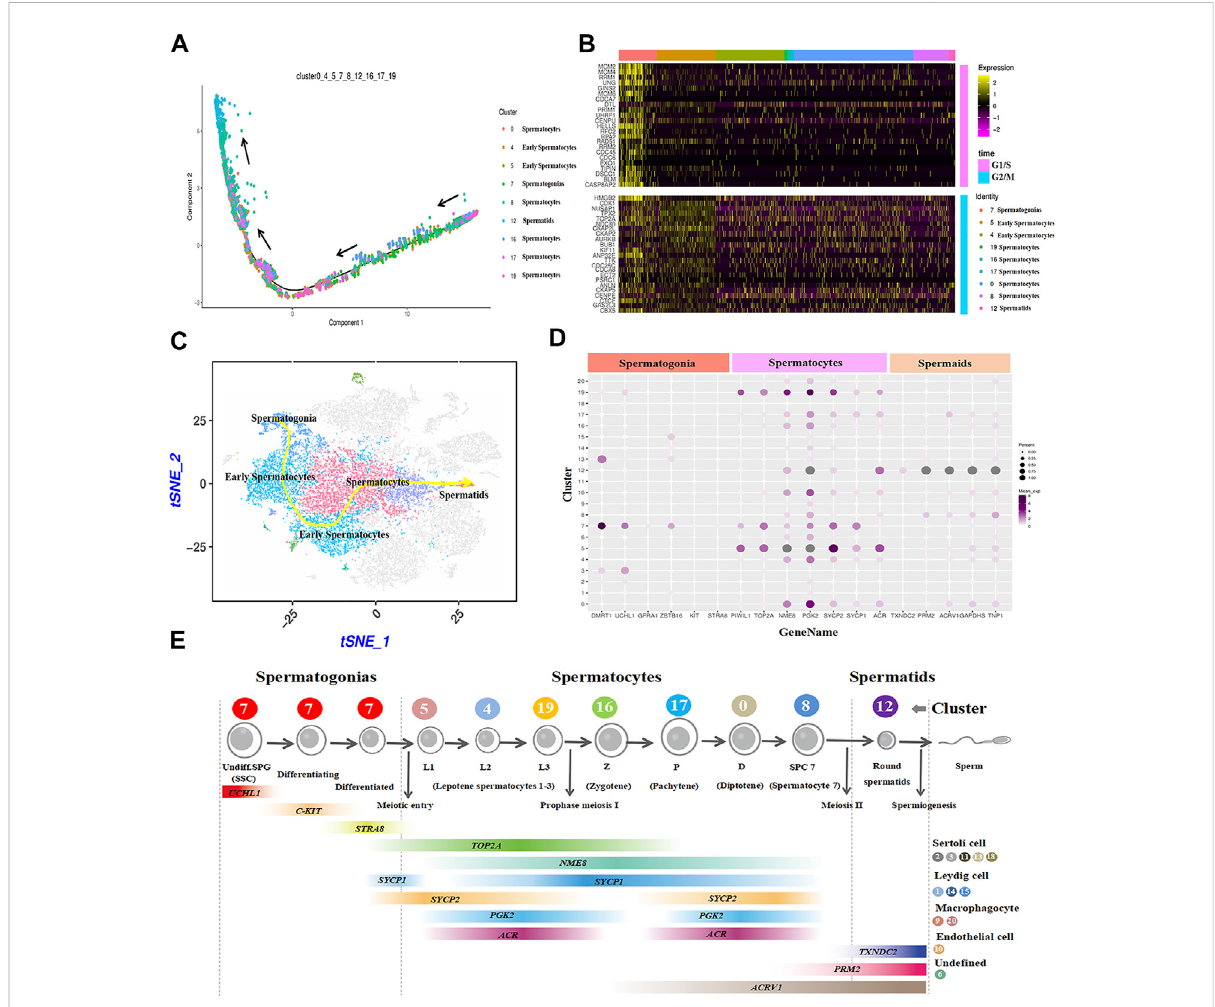
FIGURE 5 Construction of germ cell differentiation lineage in dairy goats and regulating gene expression patterns. (A) Cell trajectory analysis of nine testicular germ cell types. (B) Heat map of cell-cycle-speci fi cgenes in male dairy goat germ cells. (C) The indicator map of germ cell developmental changes. (D) Dot plot illustrating of germ cells key genes expressed in cell clusters. (E) Identi fi cation of cell clusters expressing the noted marker genes allowed clusters to be aligned with speci fi c spermatogenic cell